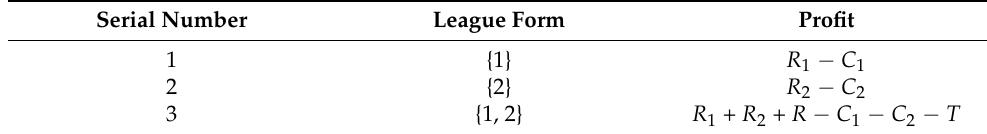
Table 3. Expected earnings of different alliances.